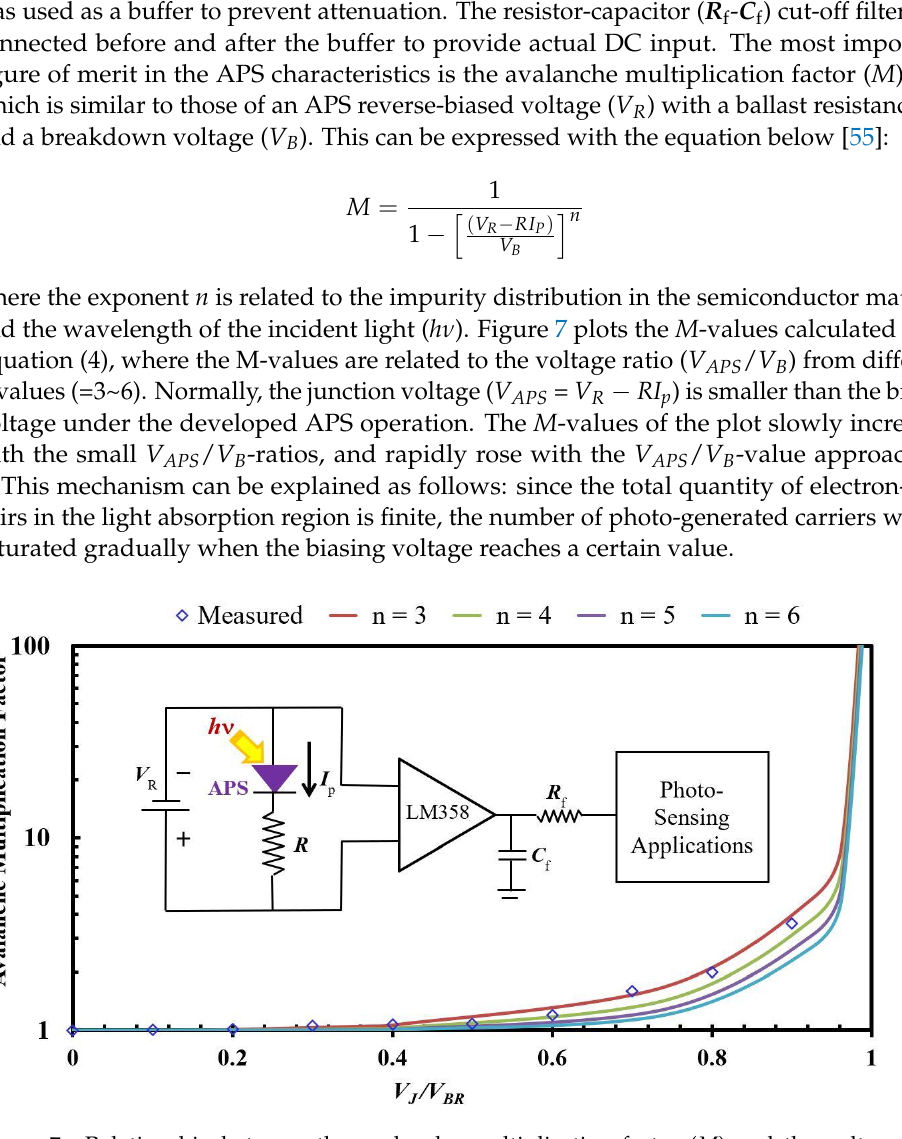
Figure 7. Relationship between the avalanche multiplication factor ( M ) and the voltage ratio ( V APS / V B ) from different n -values (=3~6), which was measured from the circuit diagram for the photo-sensing and optical communication applications, as shown in the inset. These theoretical calculations are also compared with the experimental results under n = 3